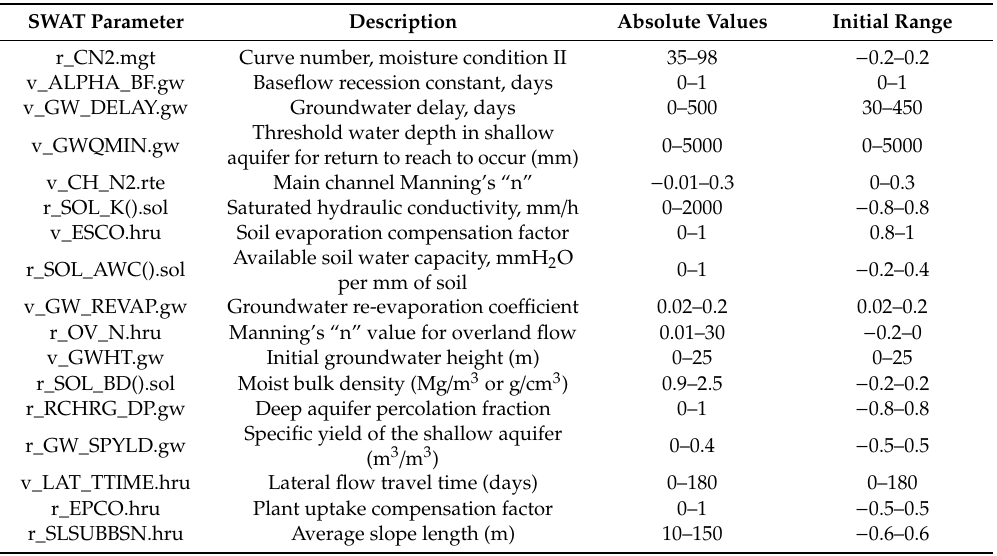
Table 4. Calibration parameters and initial ranges used in SWAT-CUP. The letter “r” indicates a relative change in value, while the letter “v” indicates a replacement. Parameter descriptions are available in Neitsch et al.